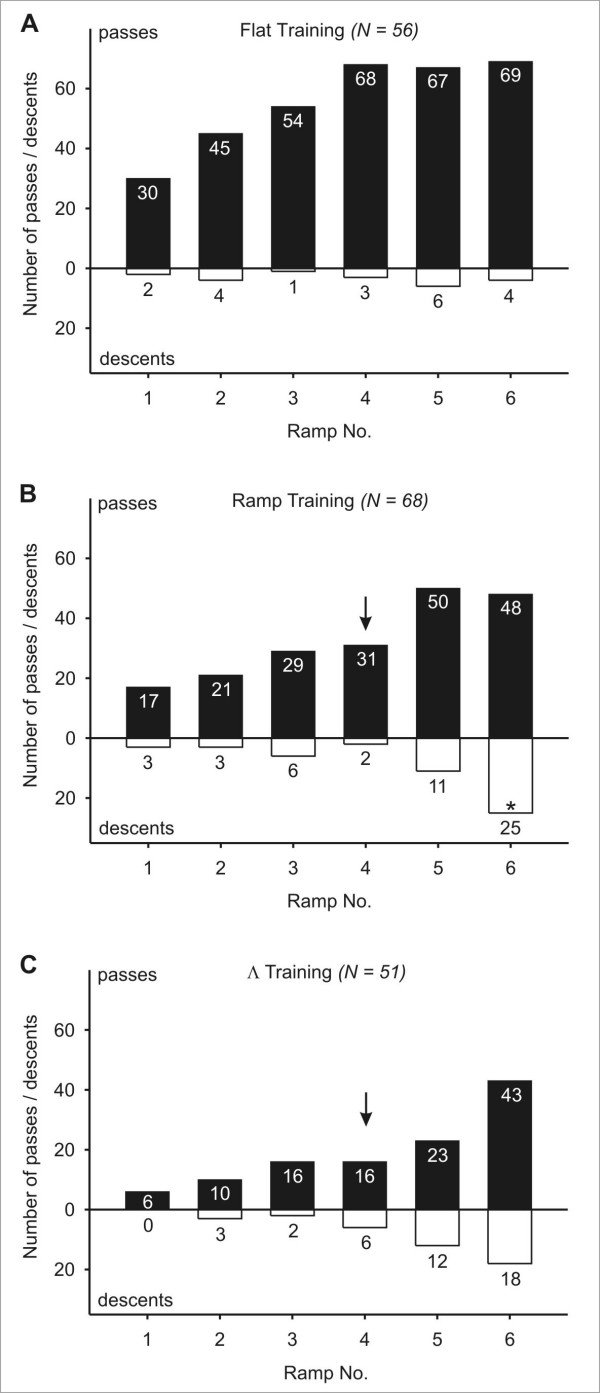
Experiment 1: Choice between different ramps. Decisions of ants to descend (white bars) or to pass (black bars) at the six ramps that were on offer. Ramp No. 1 was located nearest to the nest; ramp No. 6 was nearest to the position of the feeder and was thus encountered first on the examined homeward runs. The black arrow indicates the ramp that corresponded to the ascending ramp during training. (A) Flat training; (B) Ramp training: a significantly higher proportion of animals descended at ramp No. 6 (p < 0.05, χ2 homogeneity test and squared standardized residuals); (C) Λ training. Flat and Λ training: Due to low expected frequencies, no deviation from a uniform distribution could be detected.